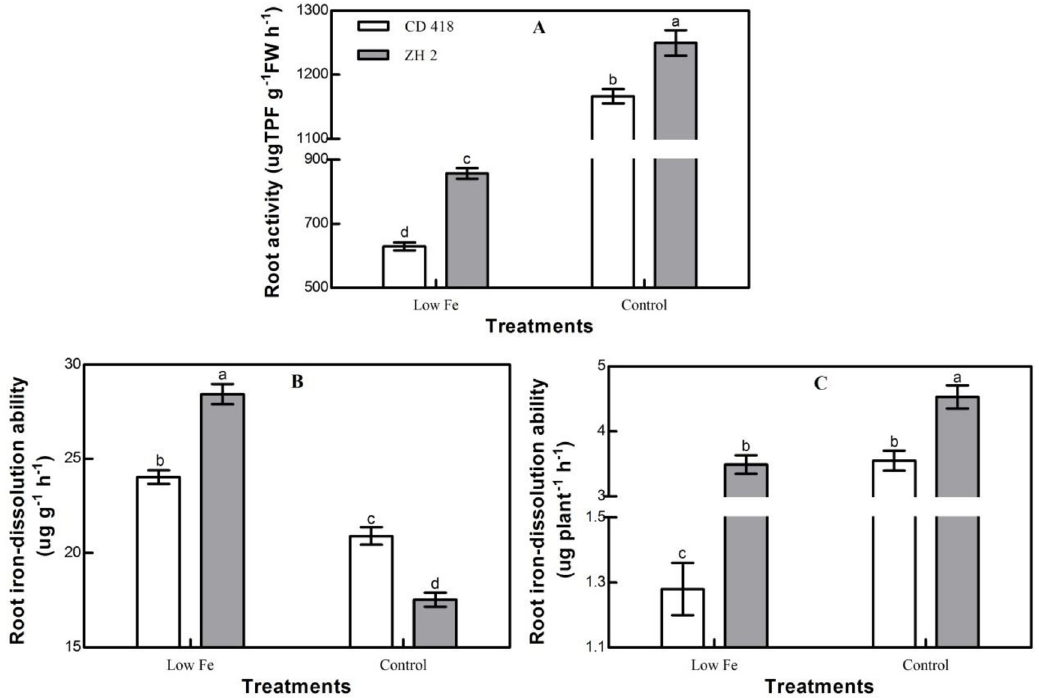
Fig 4. Root activity and Fe-dissolution ability of two maize cultivars grown under different Fe concentrations. Data are the mean ± SE of three replicate pots. Values with different lowercase letters are significantly different at p < 0.05.